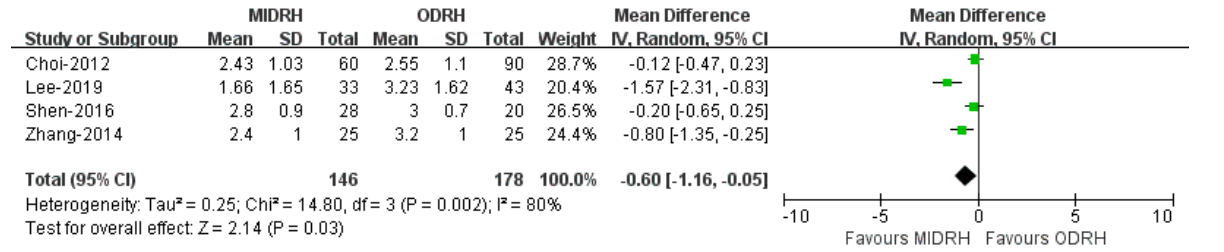
Figure 11. Forest plot and funnel plot comparison of MIDRH versus ODRH for self-infused morphine pump (days) [12,16,19,21].